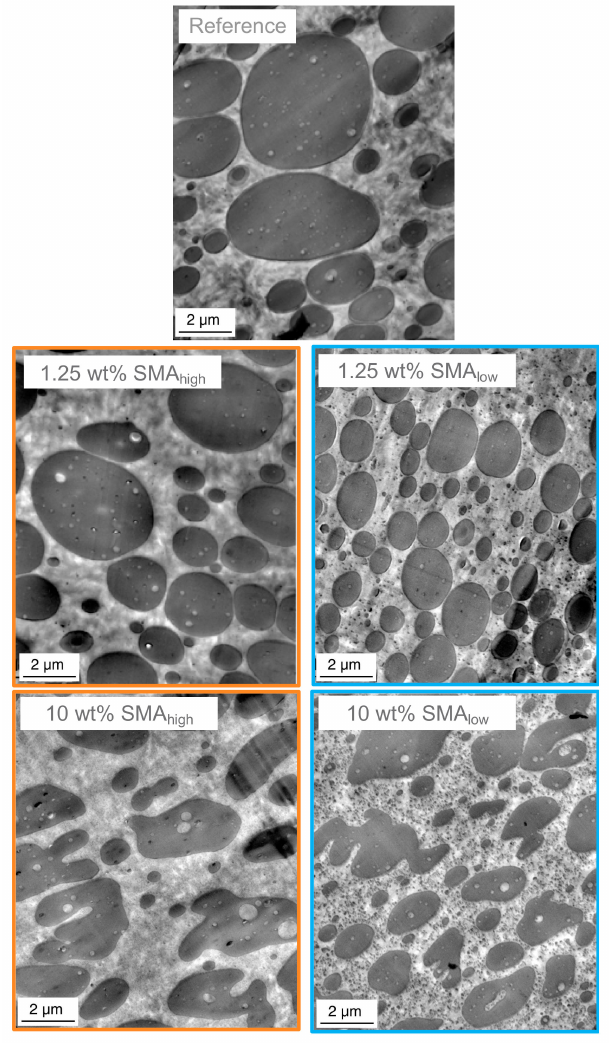
Figure 5. TEM micrographs of SMA compatibilized PA66 / PPE ternary blends, with SMA high (left column) and SMA low (right